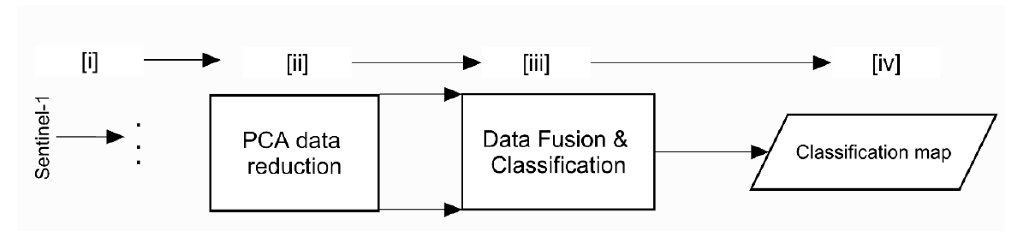
Figure 3. Schematic illustration of the experimental design.